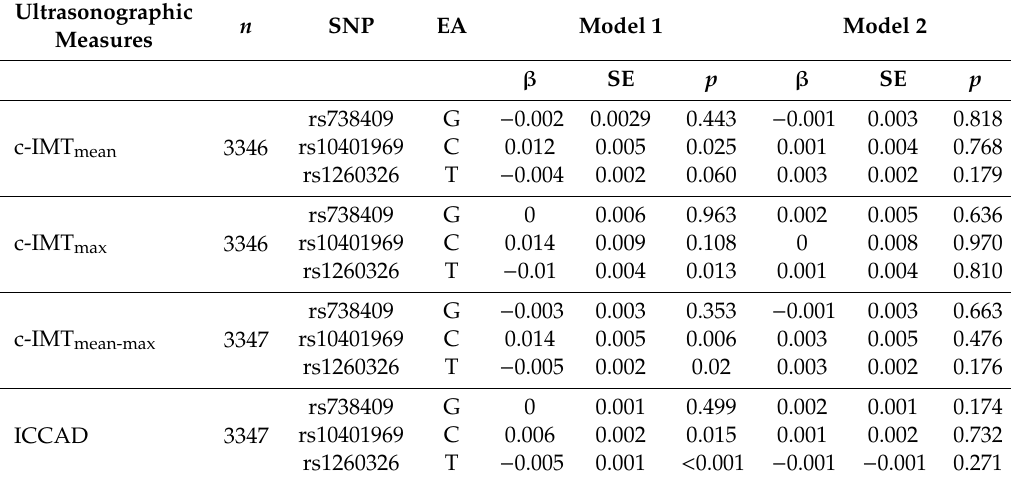
Table 2. Association of rs738409 (C / G), rs10401969 (T / C), and rs1260326 (C / T) with c-IMT measures and ICCAD.